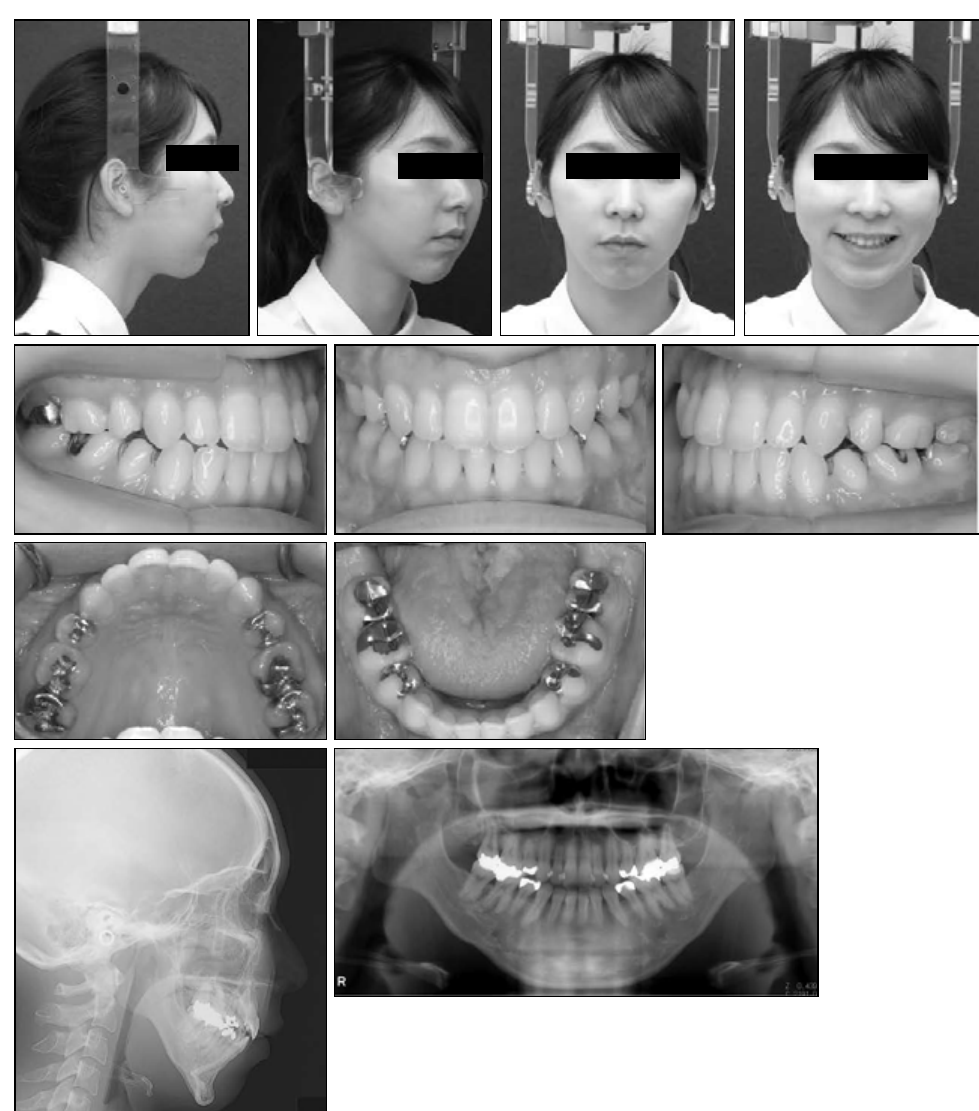
Figure 5. Post-five-year retention photographs and